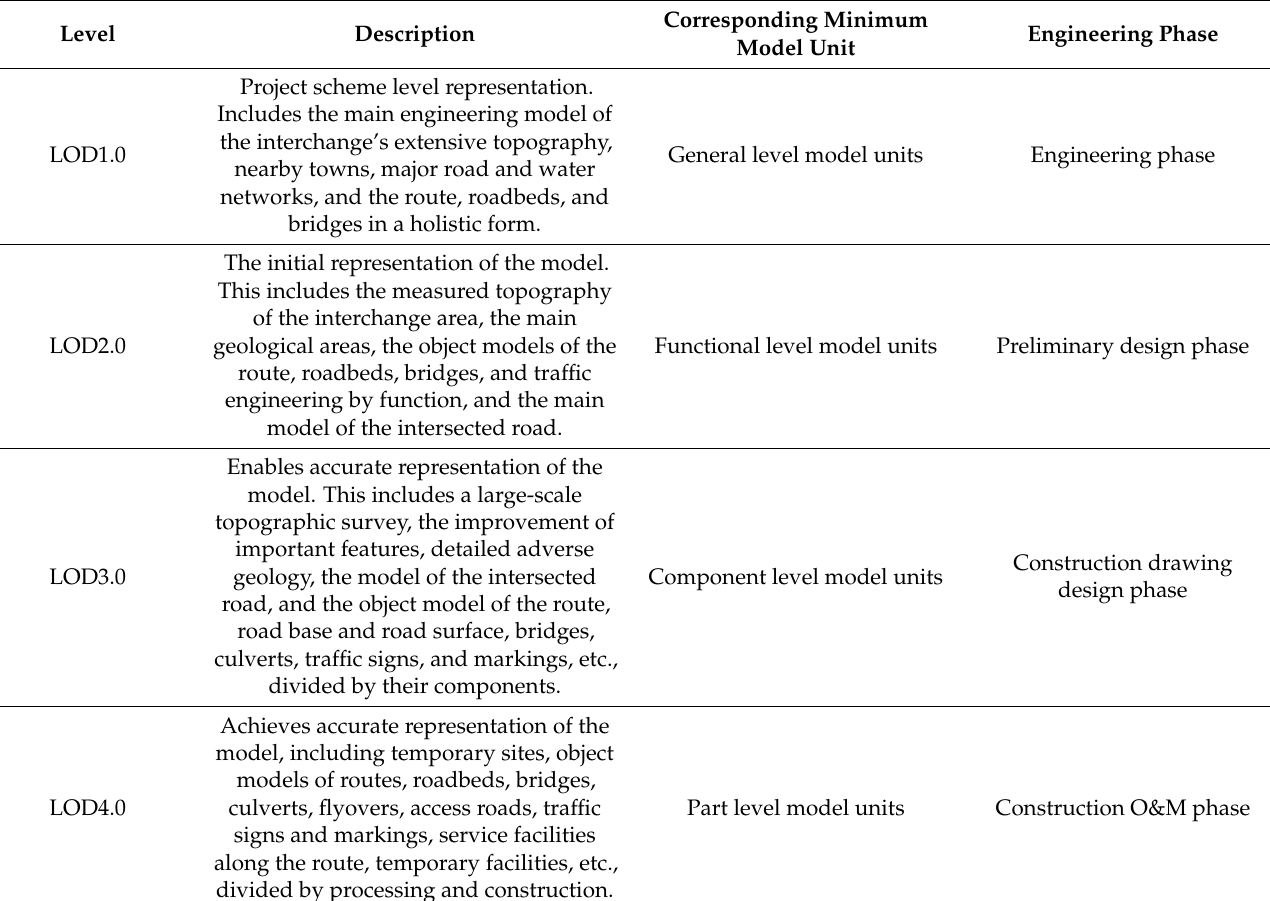
Table 3. Classification of BIM components